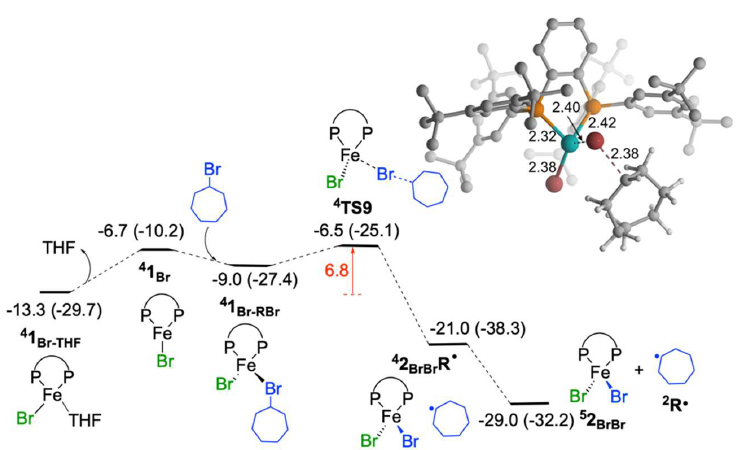
Figure 5. Free energy profile for probable reaction path of generated iron(I) species. Free energies with respect to 5 2 PhBr and bromocycloheptane are given in kcal/mol (ΔE ZPE are given in parenthesis).